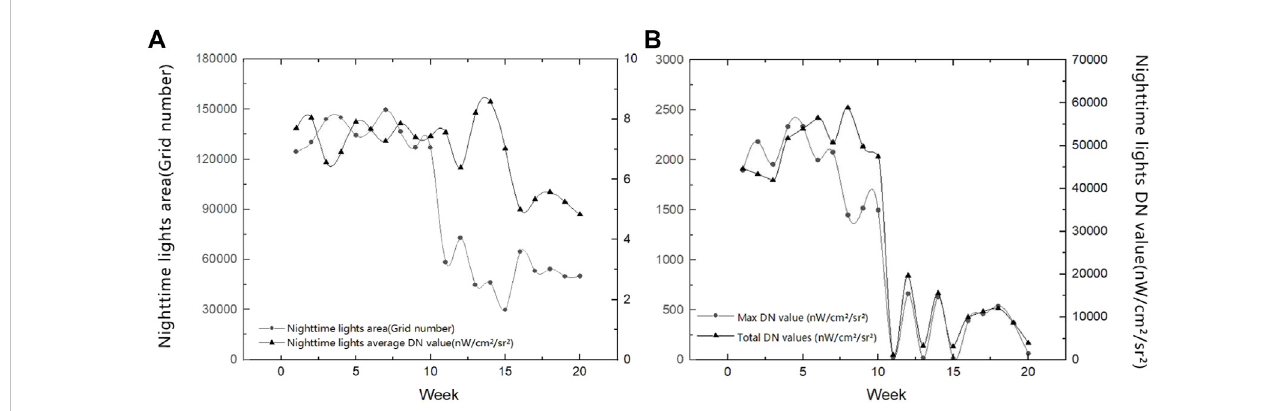
FIGURE 3 Weekly nighttime lights area trends (A) and nighttime lights DN value changes (B) in Ukraine from 16 December 2021 to 2 May